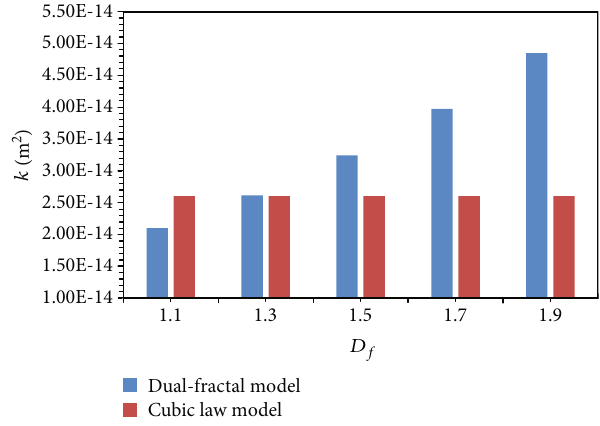
Figure 15: Permeability evolution under di ff erent fractal dimension of fracture length.